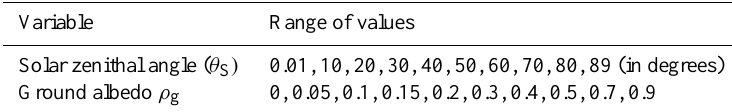
Table 1. Range of values taken by θ S and ρ g .